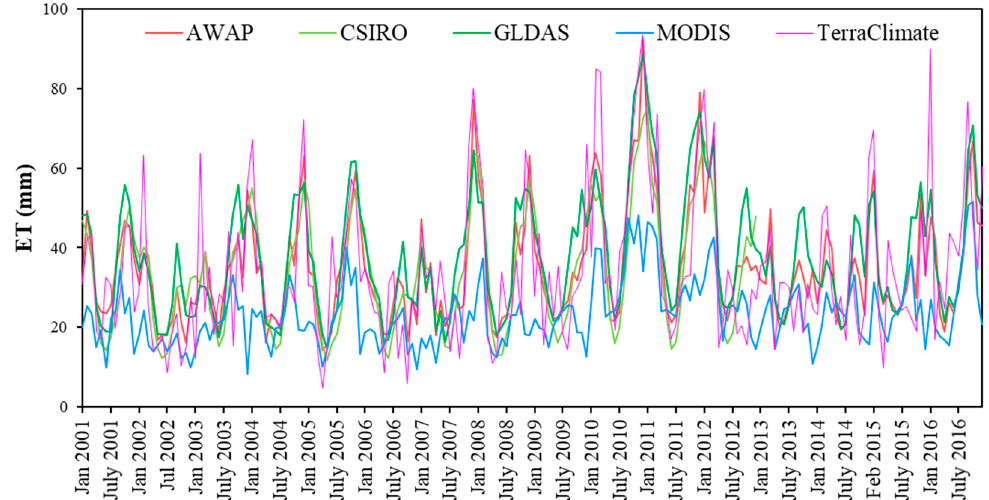
Figure 3. Monthly average evapotranspiration in Murray Darling Basin presented with different precipitation products.